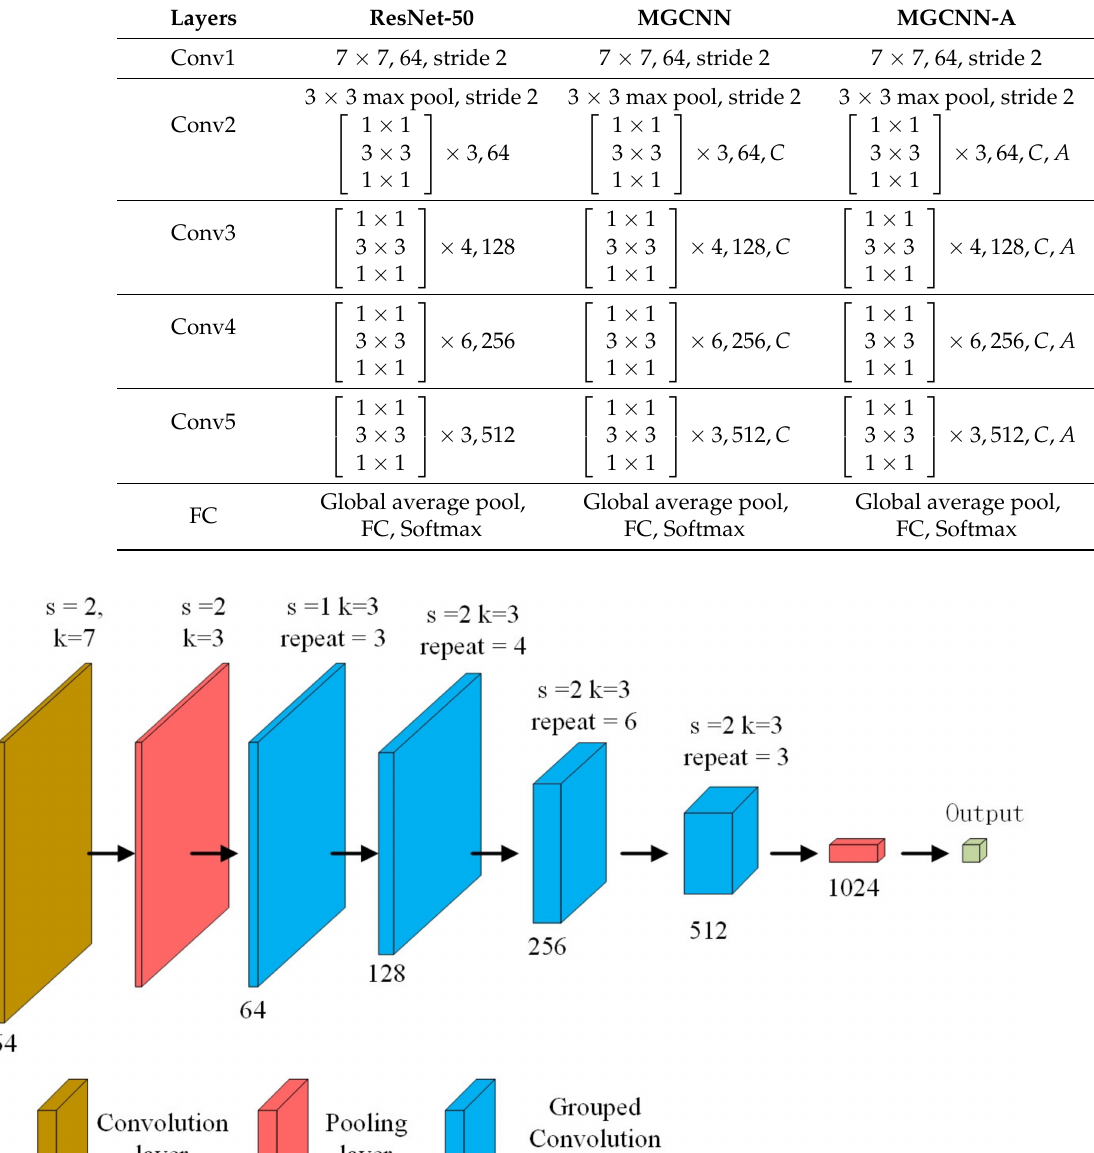
Table 1. The basic framework of the three models.